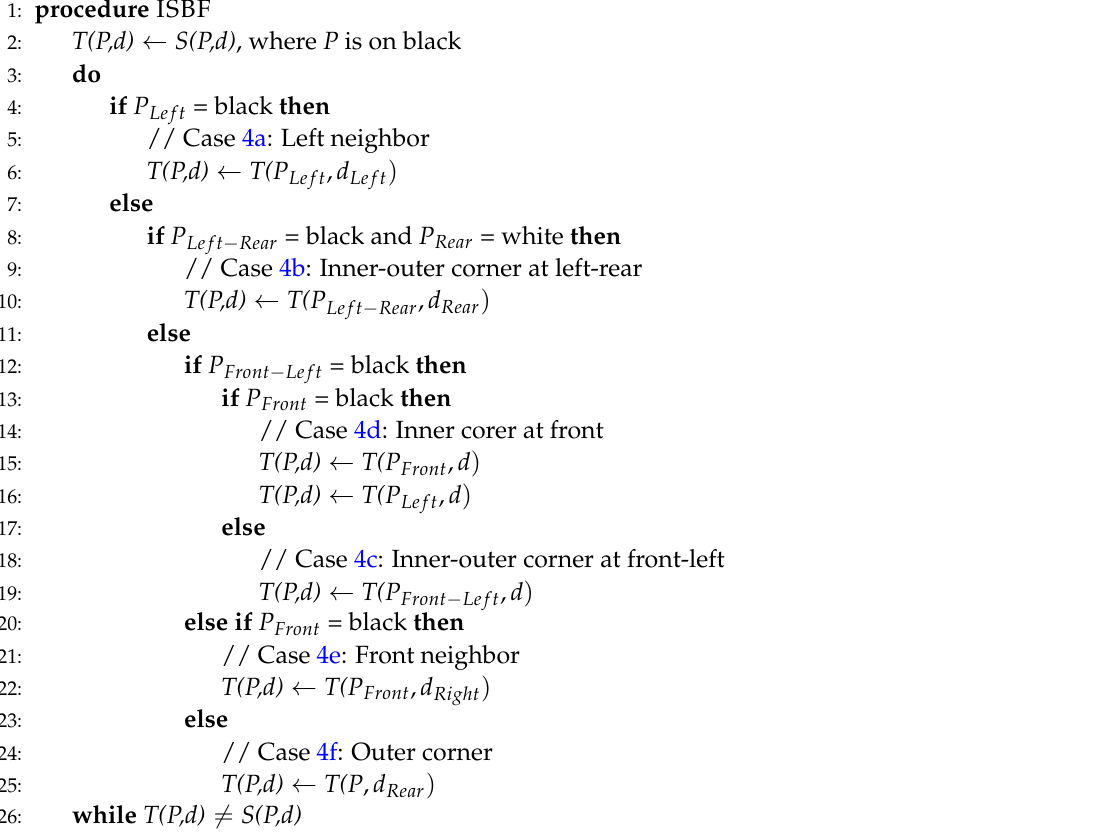
Algorithm 2 Algorithm of the improved simple boundary